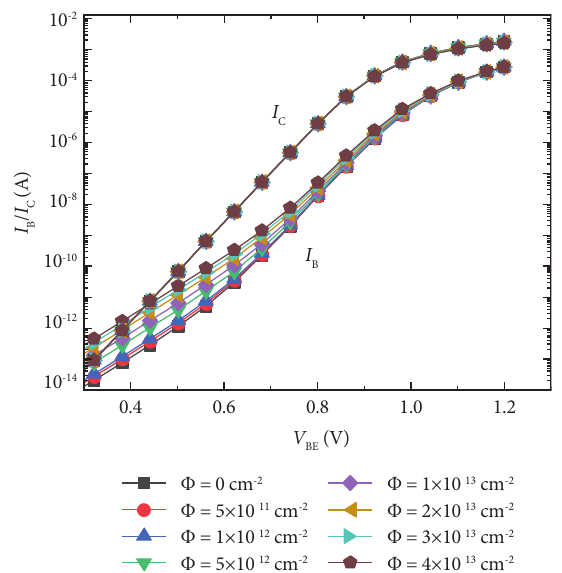
Figure 2: Gummel characteristics of NPN BJT after neutron